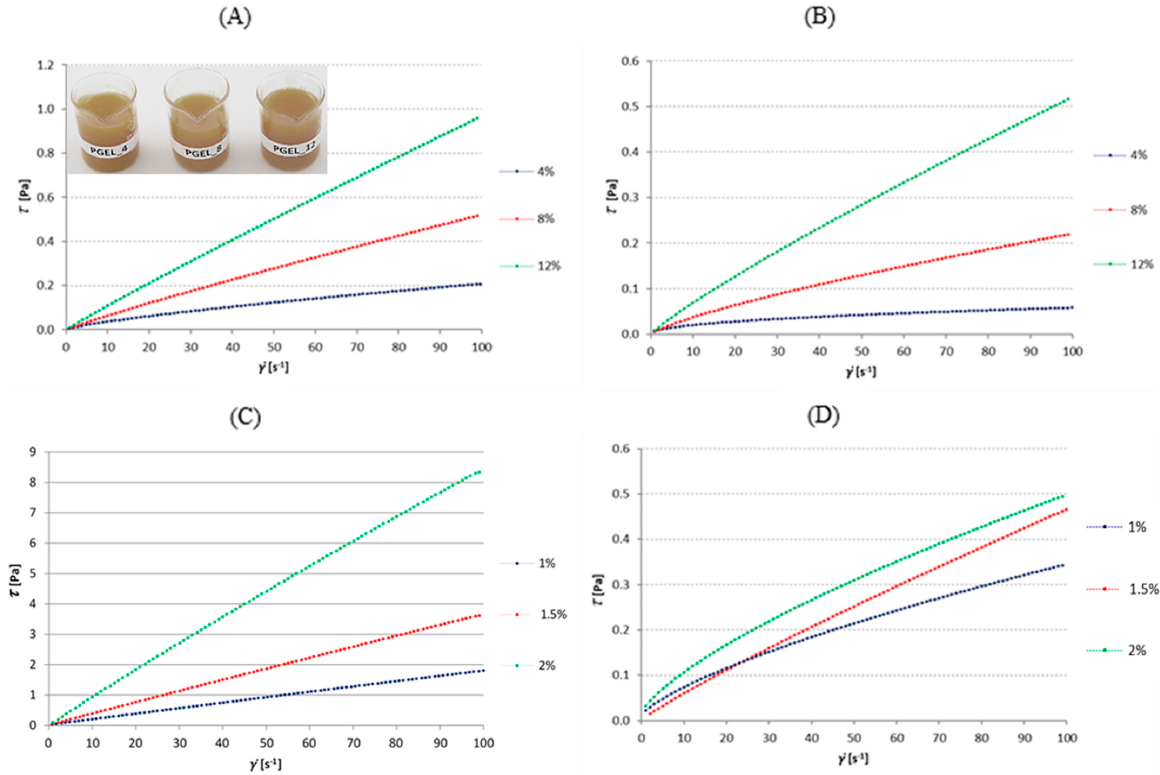
Figure 1. Flow curves of tested hydrocolloids solutions of various concentrations: ( A )—gelatin, ( B )—soy protein isolate, ( C )—sodium alginate, and ( D )—high-methylated apple pectin. The figure also includes a photo of the tested gelatin solutions (PGEL_4, 8, 12)